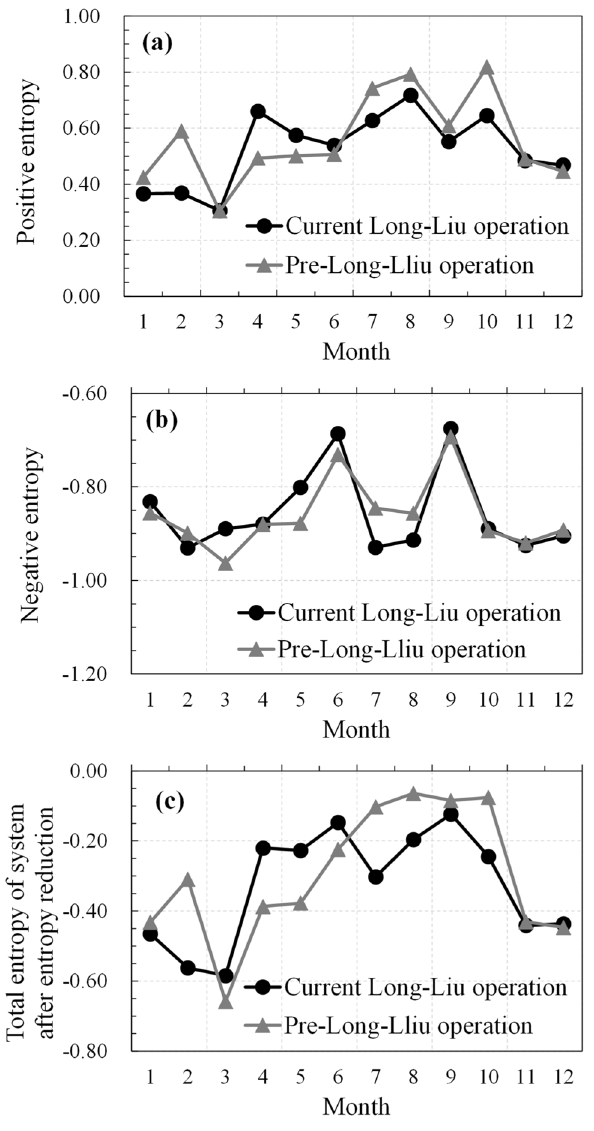
Figure 4. Comparison of the positive, negative and total entropy levels in the current situation and pre-Long- Liu operation state in the different months throughout the